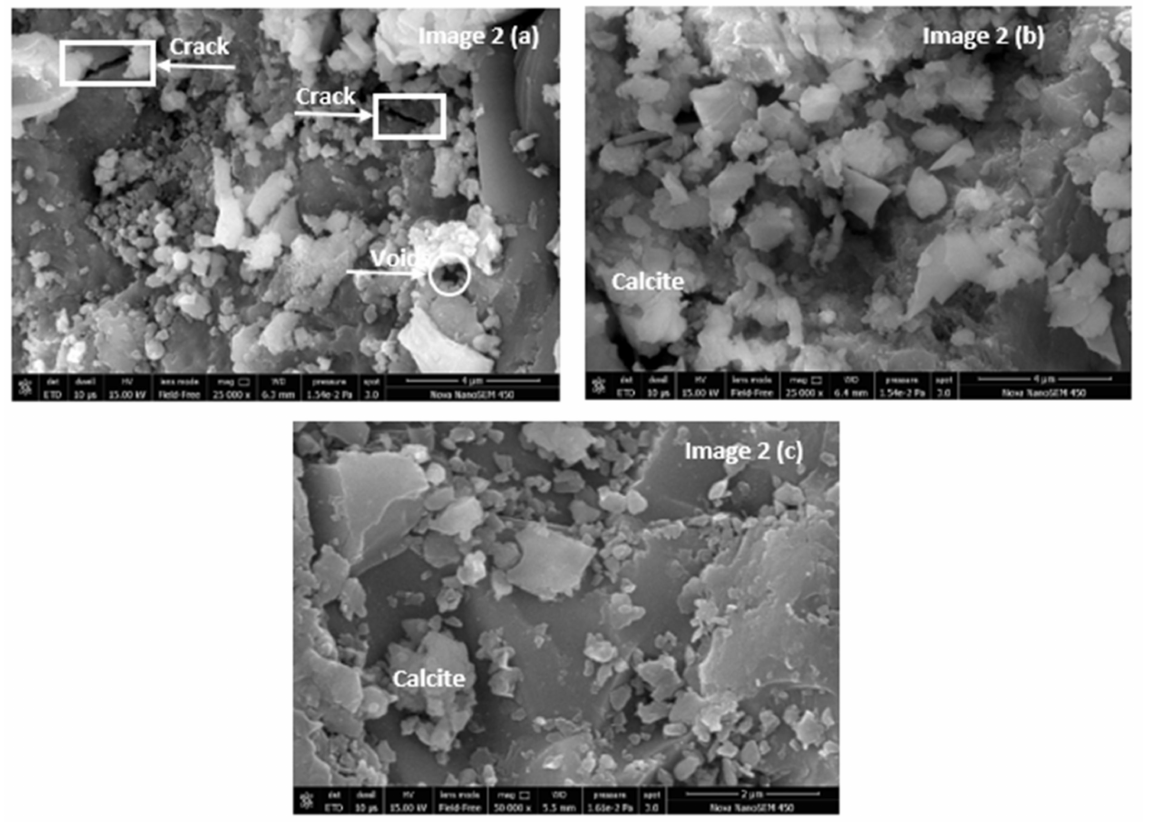
Figure 10. SEM image of conventional concrete and bacterial concrete for 180 days. Image 2 ( a ) conventional concrete sample after 180 days, Image 2 ( b ) 10 6 cf/mL Pseudomonas Bacterial concrete after 180 days, and Image 2 ( c ) 10 7 cf/mL Pseudomonas Bacterial concrete after 180